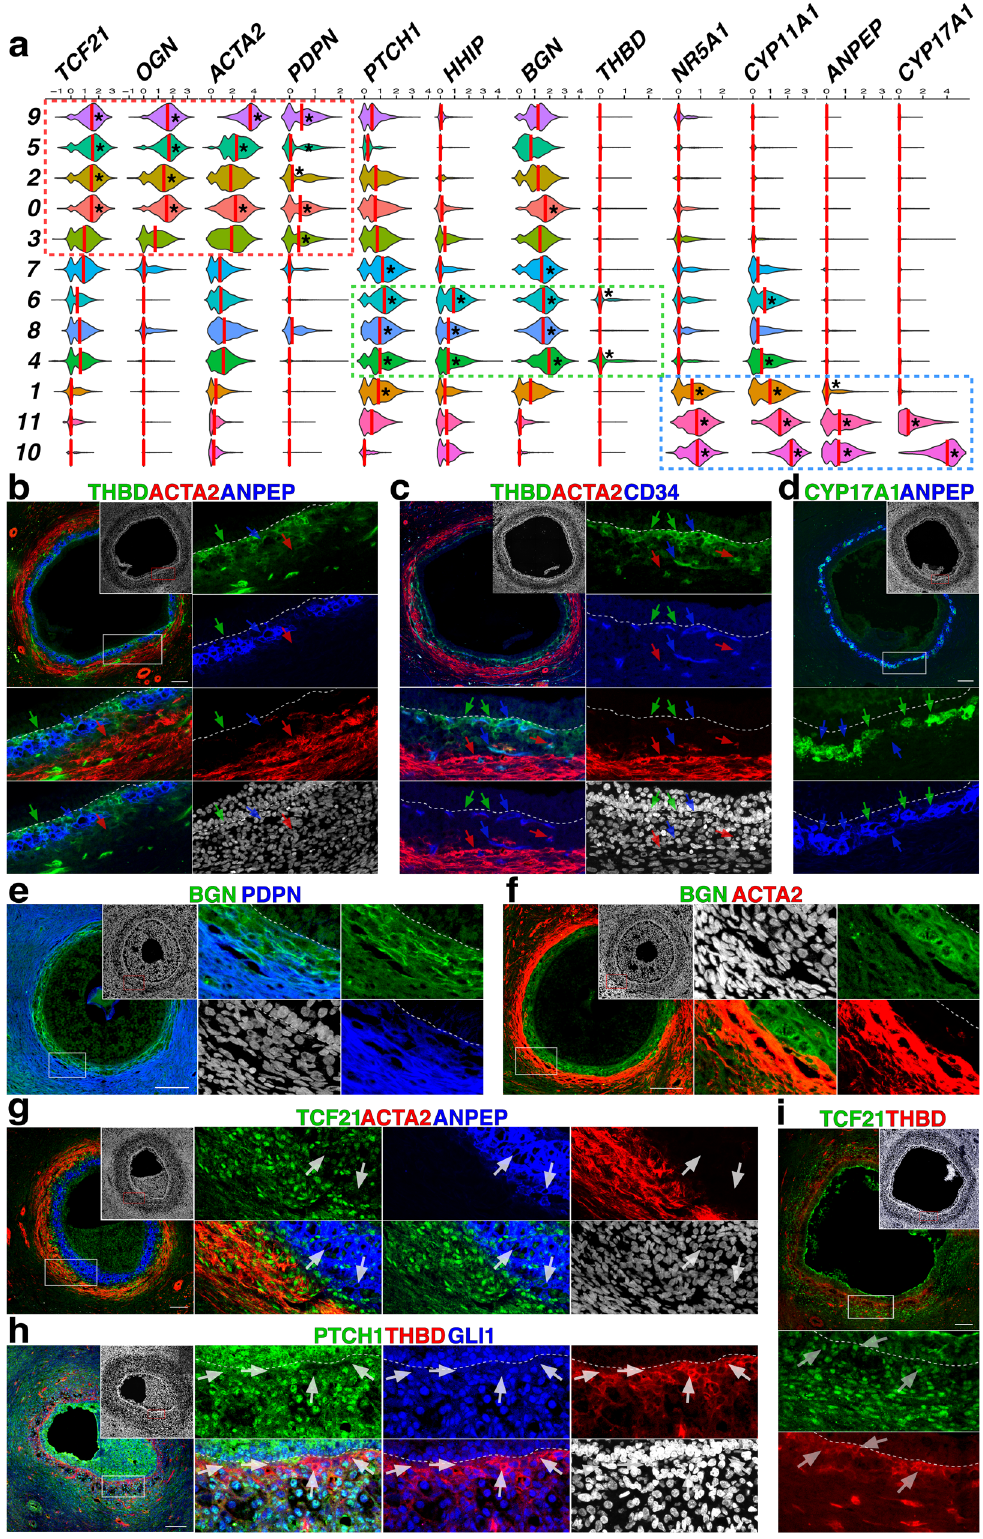
4 transcripts allowed us to distinguish anatomically distinct layers among the theca/stroma of antral follicles (dotted lines in Fig. 1a): GC basement membrane-associated HHIP + and NR5A1 + cells residing within a PTCH1 + region that overlaps with a gradient of TCF21 + cells that demarcate the outer limit of the theca/stroma